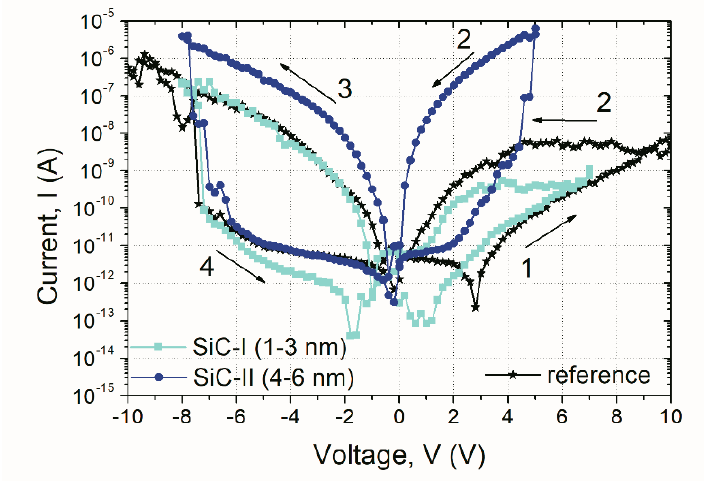
Figure 10. Comparison of representative resistive switching I–V curves of NC-MIM and reference MIM devices investigated in this work; the numbers indicate the sequence of measurements.